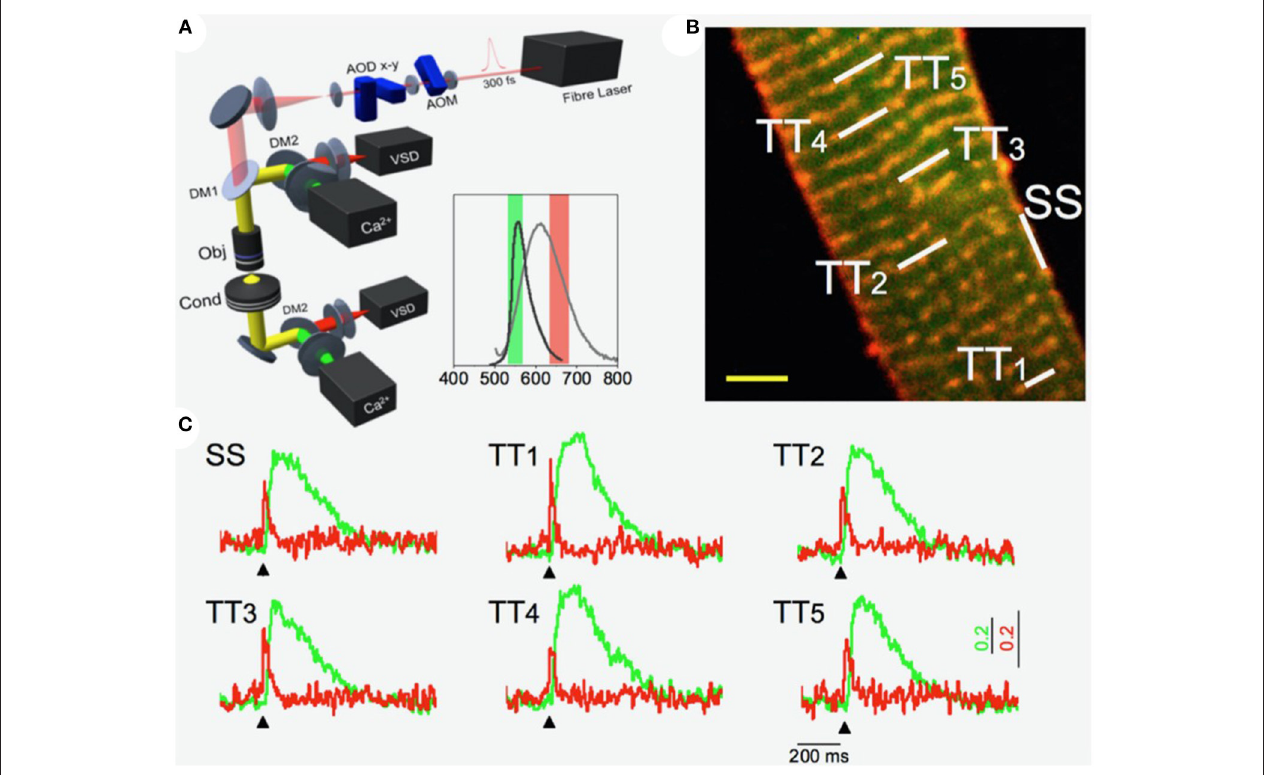
FIGURE 1 | Multi-site voltage and Ca 2+ recording. (A) Scheme of the Random Access Multi-Photon (RAMP) microscope based on two orthogonally-mounted acousto-optical deflectors (AODs -x and -y) for laser scanning. Inset shows the emission spectra of the Ca 2+ indicator (in dark gray) and voltage sensitive dye (in light gray) together with their fluorescence filter acquisition band. (B) Image of a stained rat ventricular cardiac cell: di-4-ANE(F)PPTEA in red and GFP-certified Fluoforte in green. Scale bar: 5 µ m (C) Real time fluorescence traces collected from the scanned sites indicated in white in (B) : surface sarcolemma (SS) and five T-tubules (TTi). Membrane voltage is shown in red and Ca 2+ in green. Reproduced and modified from Crocini et al. (2014).